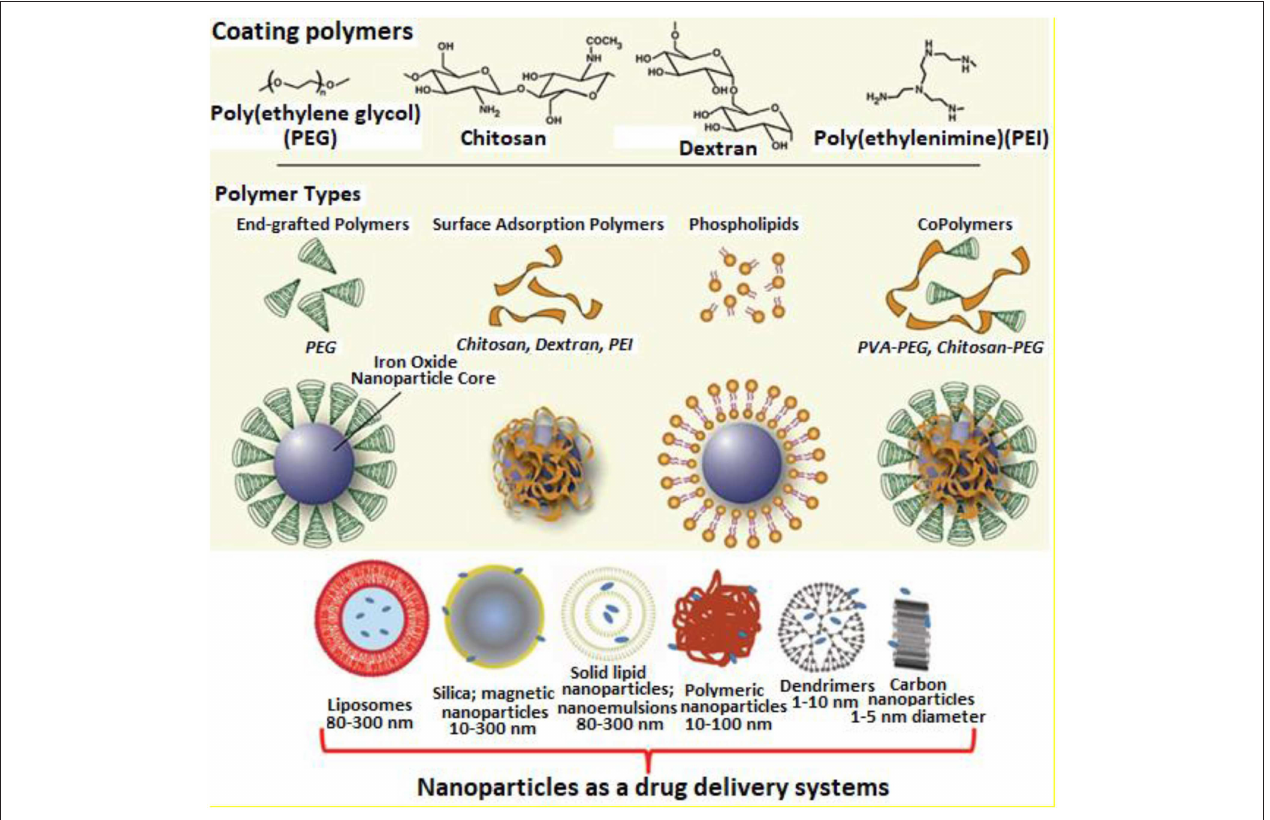
FIGURE 9 | Novel drug-carrier systems depicting different types of coating polymers and copolymers [adapted and modified from Veiseh et al.